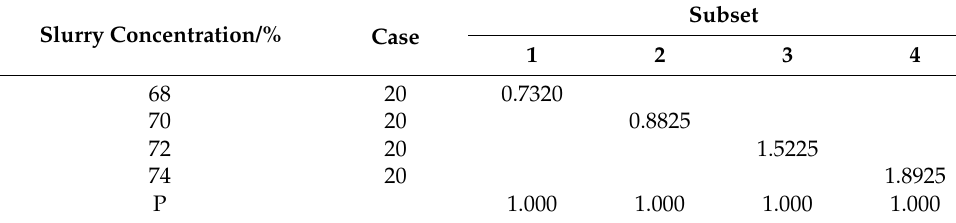
Table 4. Pairings comparison of slurry concentration.